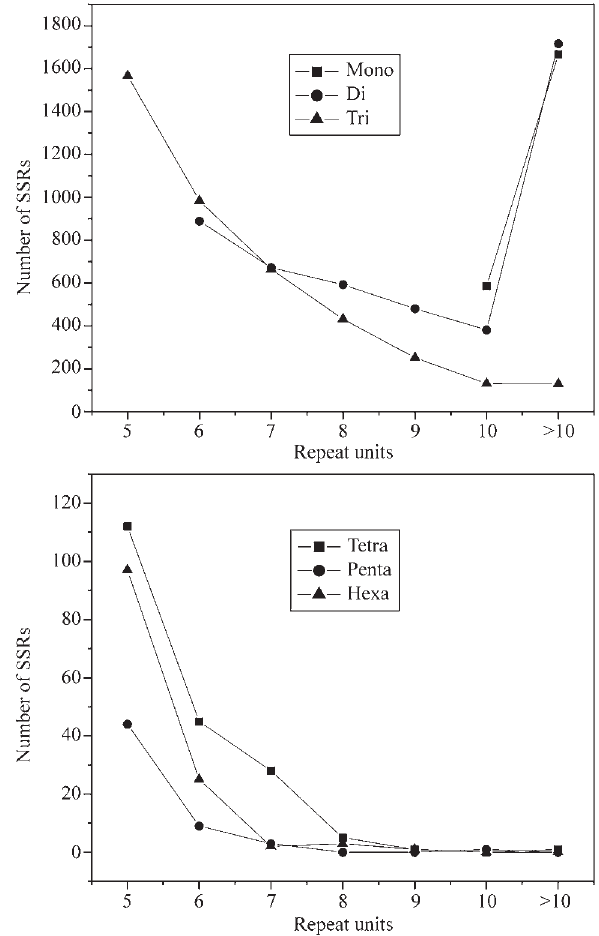
Figure4 -NumberofSSRsaccordingtonumberofrepeatunits.Thenum- ber of microsatellites in a particular repeat unit size decreases with the in- creasing number of repeat units, except for mono and dimerics. Table 2 - Repetitive elements associated to microsatellites (SSR) determined in Eucalyptus ESTs from FORESTs. SSR containing